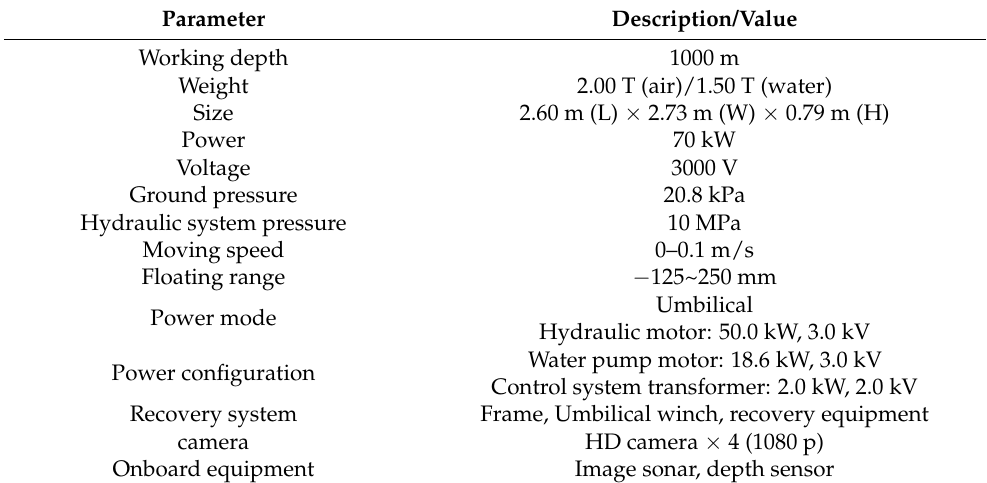
Table 8. Manipulator